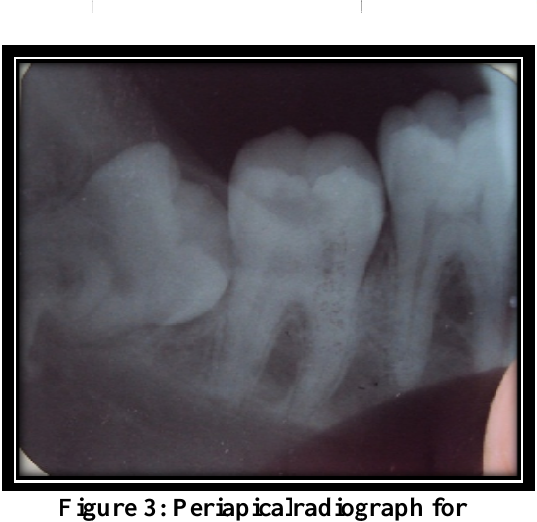
Figure Figure 3: Periapical Periapicalradiograph for impacted impacted mandibular 3